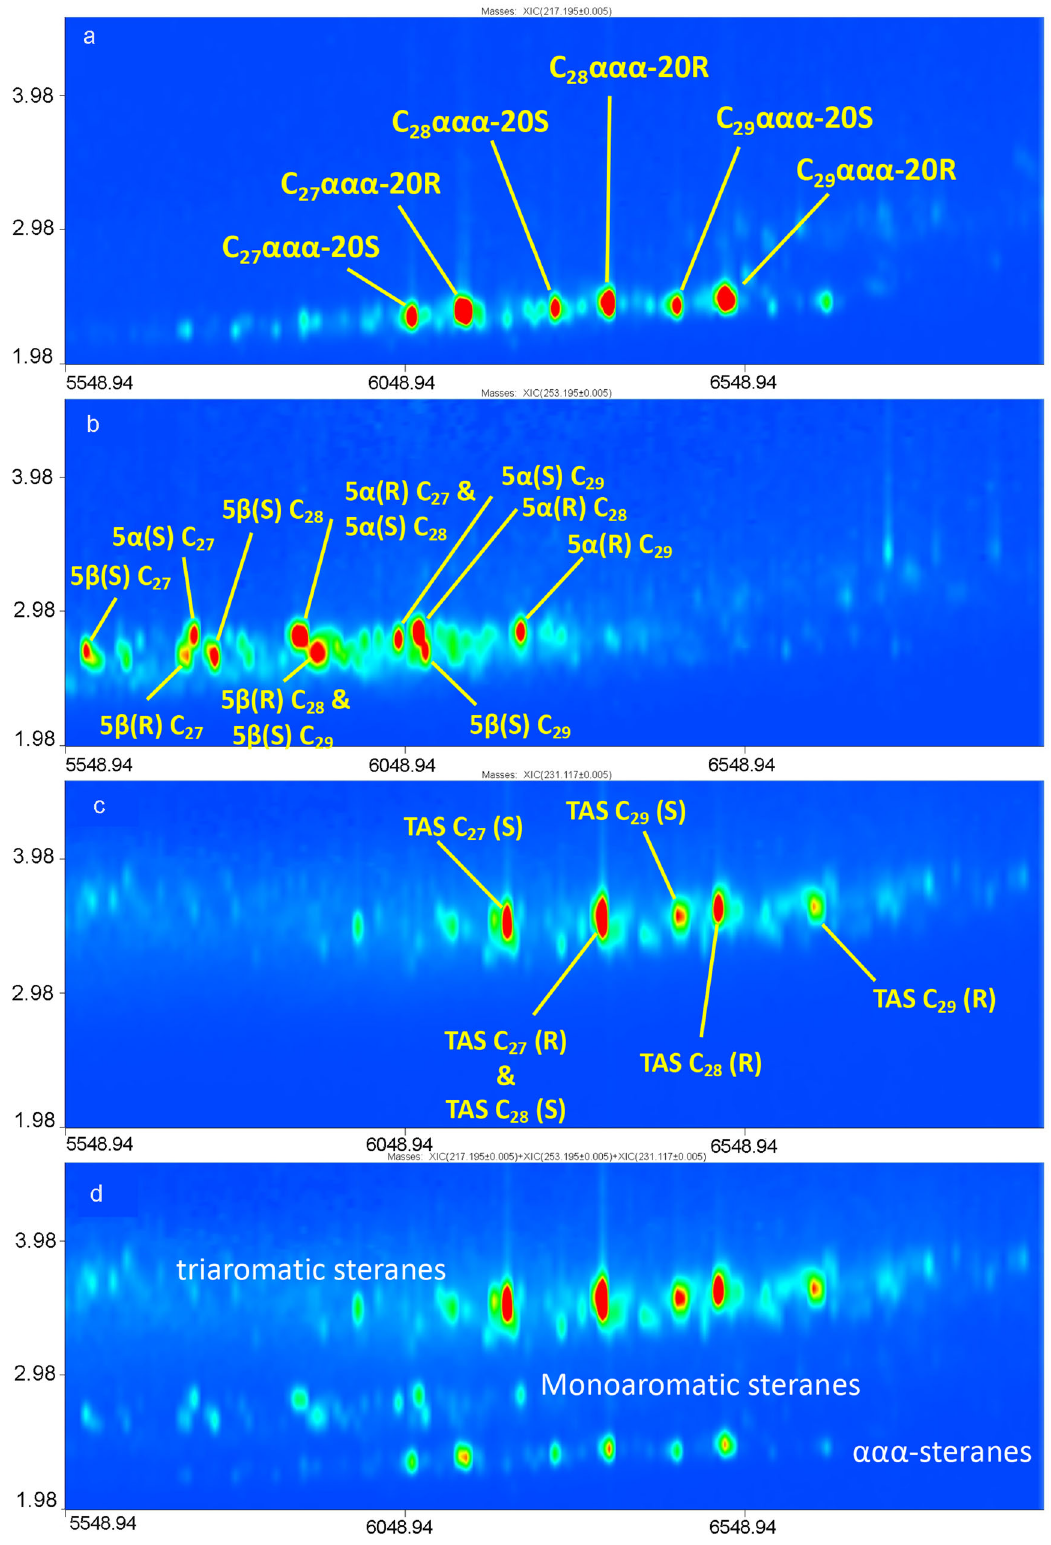
Fig. 6 GC×GC-HRT color contour plot of Cathedral Hill core 4991-7 (0 – 6 cm) which highlights the aromatization pathways of ααα -steranes. a Shows aromatization of the ααα -steranes, b shows resulting C-ring monoaromatic steroidal compounds, and c shows resulting triaromatic steroidal compounds. d Shows all compounds in overview. αββ -steranes were not observed. Selected ions, m / z 217.195 ( a ), 253.195 ( b ), 231.117 ( c ), all ±0.005 amu.